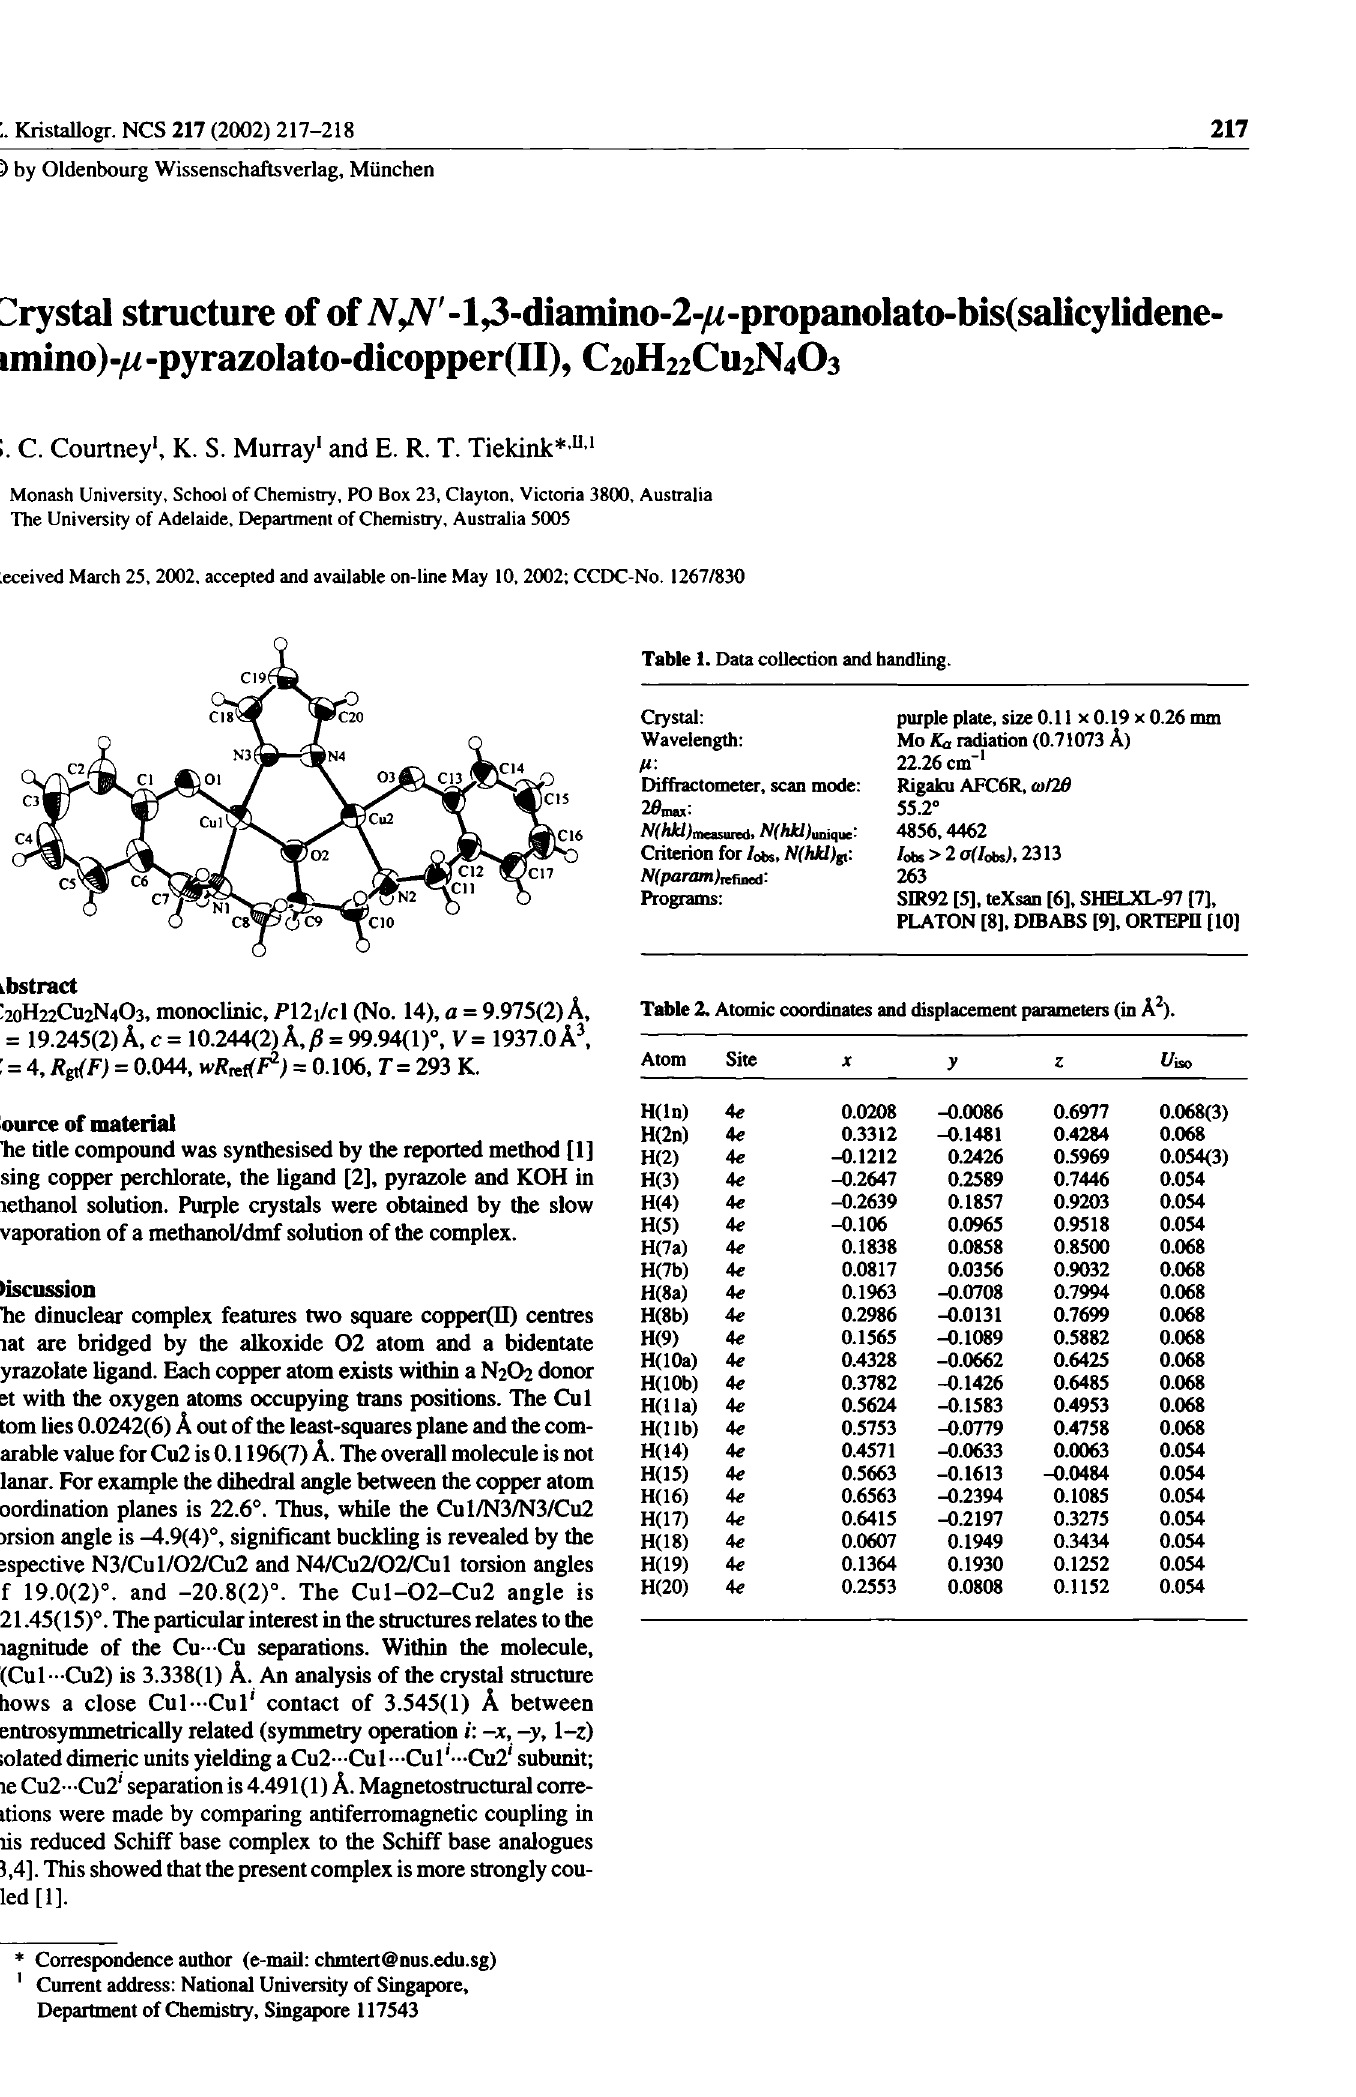
Table 1. Data collection and handling.